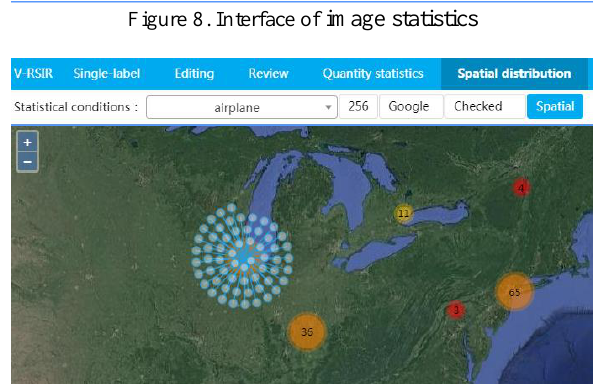
Figure 9. Interface of spatial